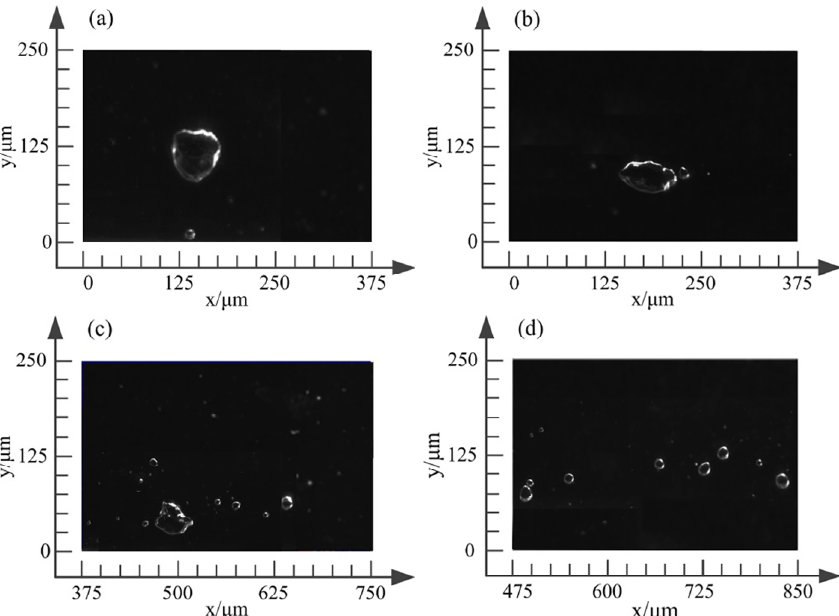
Figure 17. Experimental results of the bubble bursting near the wall at different times: (a) t = 15 μ s, (b) t = 81 μ s, (c) t = 98 μ s, (d) t = 120 μ s.